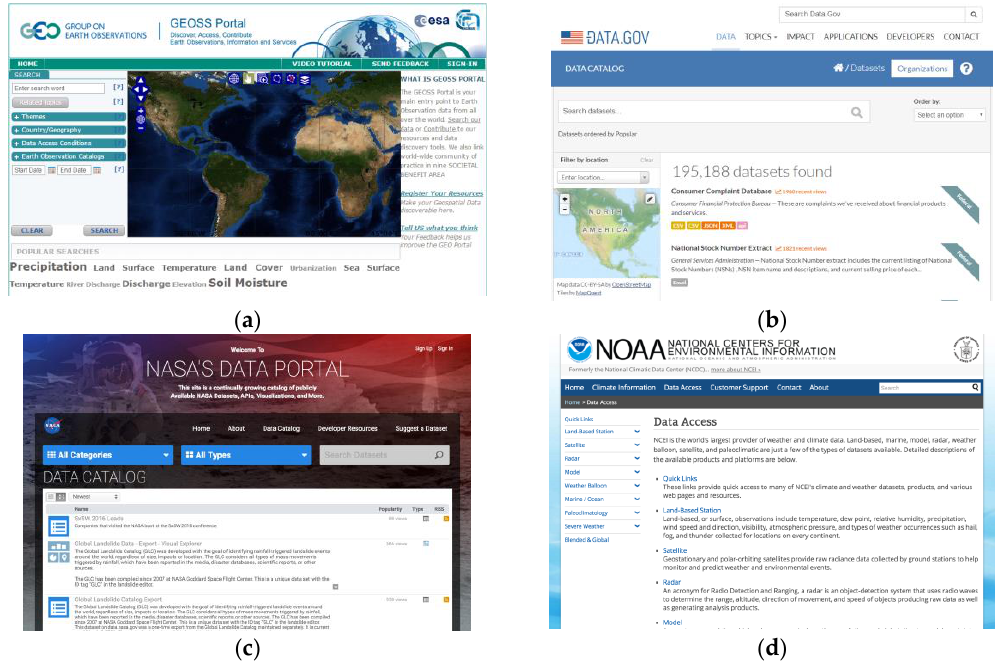
Figure 2. Examples of data portals/SDIs: ( a ) Global Earth Observation System of Systems (GEOSS); ( b ) Data.gov; ( c ) National Aeronautics and Space Administration (NASA)’s data portal; and ( d ) National Climatic Data Center.